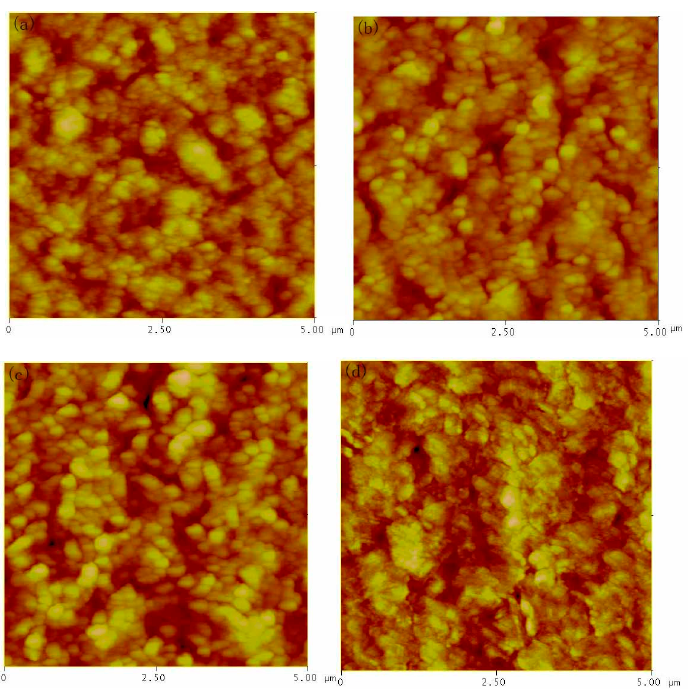
Figure 4. AFM (atomic force microscope) images of PbS CQDs thin films prepared by using different solvent ( a ) n-octane; ( b ) isooctane; ( c ) n-hexane; ( d ) toluene.